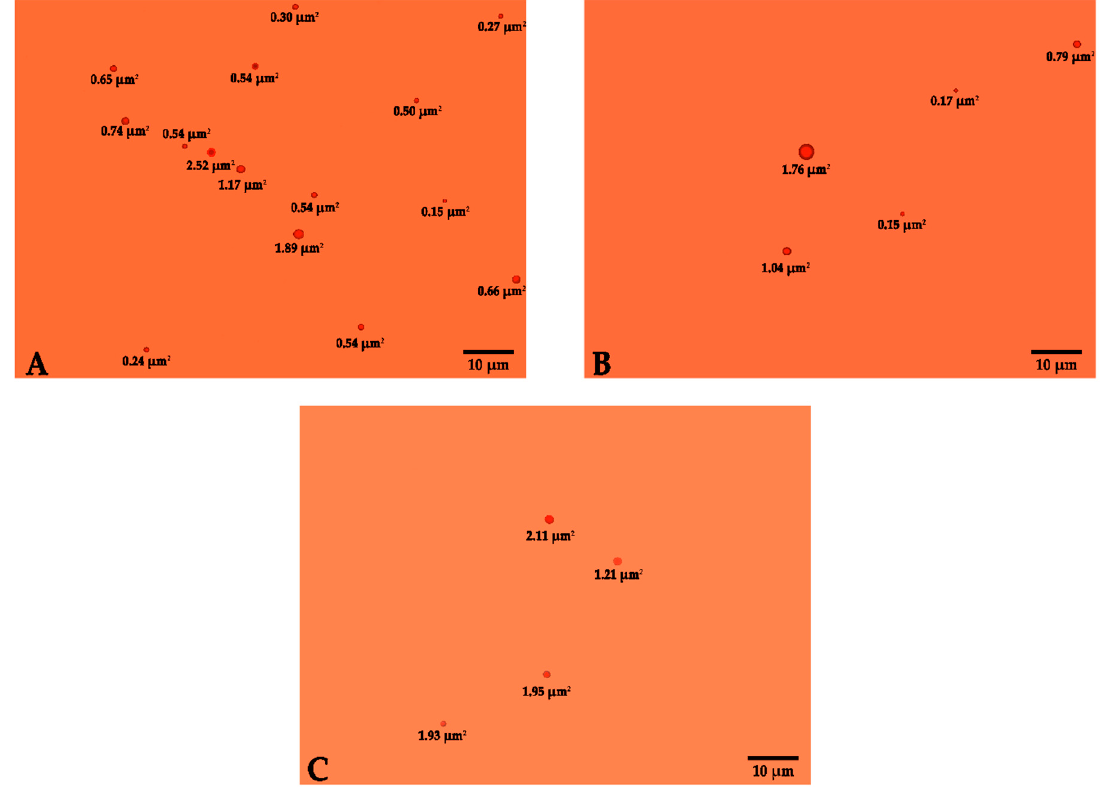
Figure 2. Micelles obtained in astaxanthin oleoresin emulsion at 10% in various dilutions in H 2 O ( v / v ) ( A ) 1:5, ( B ) 1:25 and ( C ) 1:50.